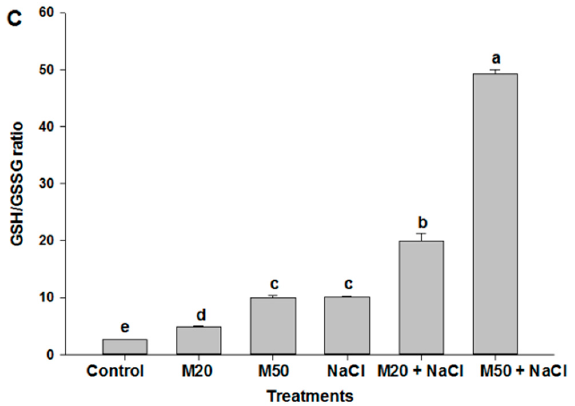
Figure 8. Effect of melatonin on the content of ( A ) reduced glutathione (GSH), ( B ) oxidized glutathione, and ( C ) ratio of GSH/GSSG in leaves of tomato seedlings under salinity. Data represent mean of 4 replicates with bars indicating SE. The bars labelled with different letters are significantly different at p < 0.05% . [ DDW (control), 20 μ M melatonin (20M), 50 μ M melatonin (50M), 100 mM NaCl (NaCl)].